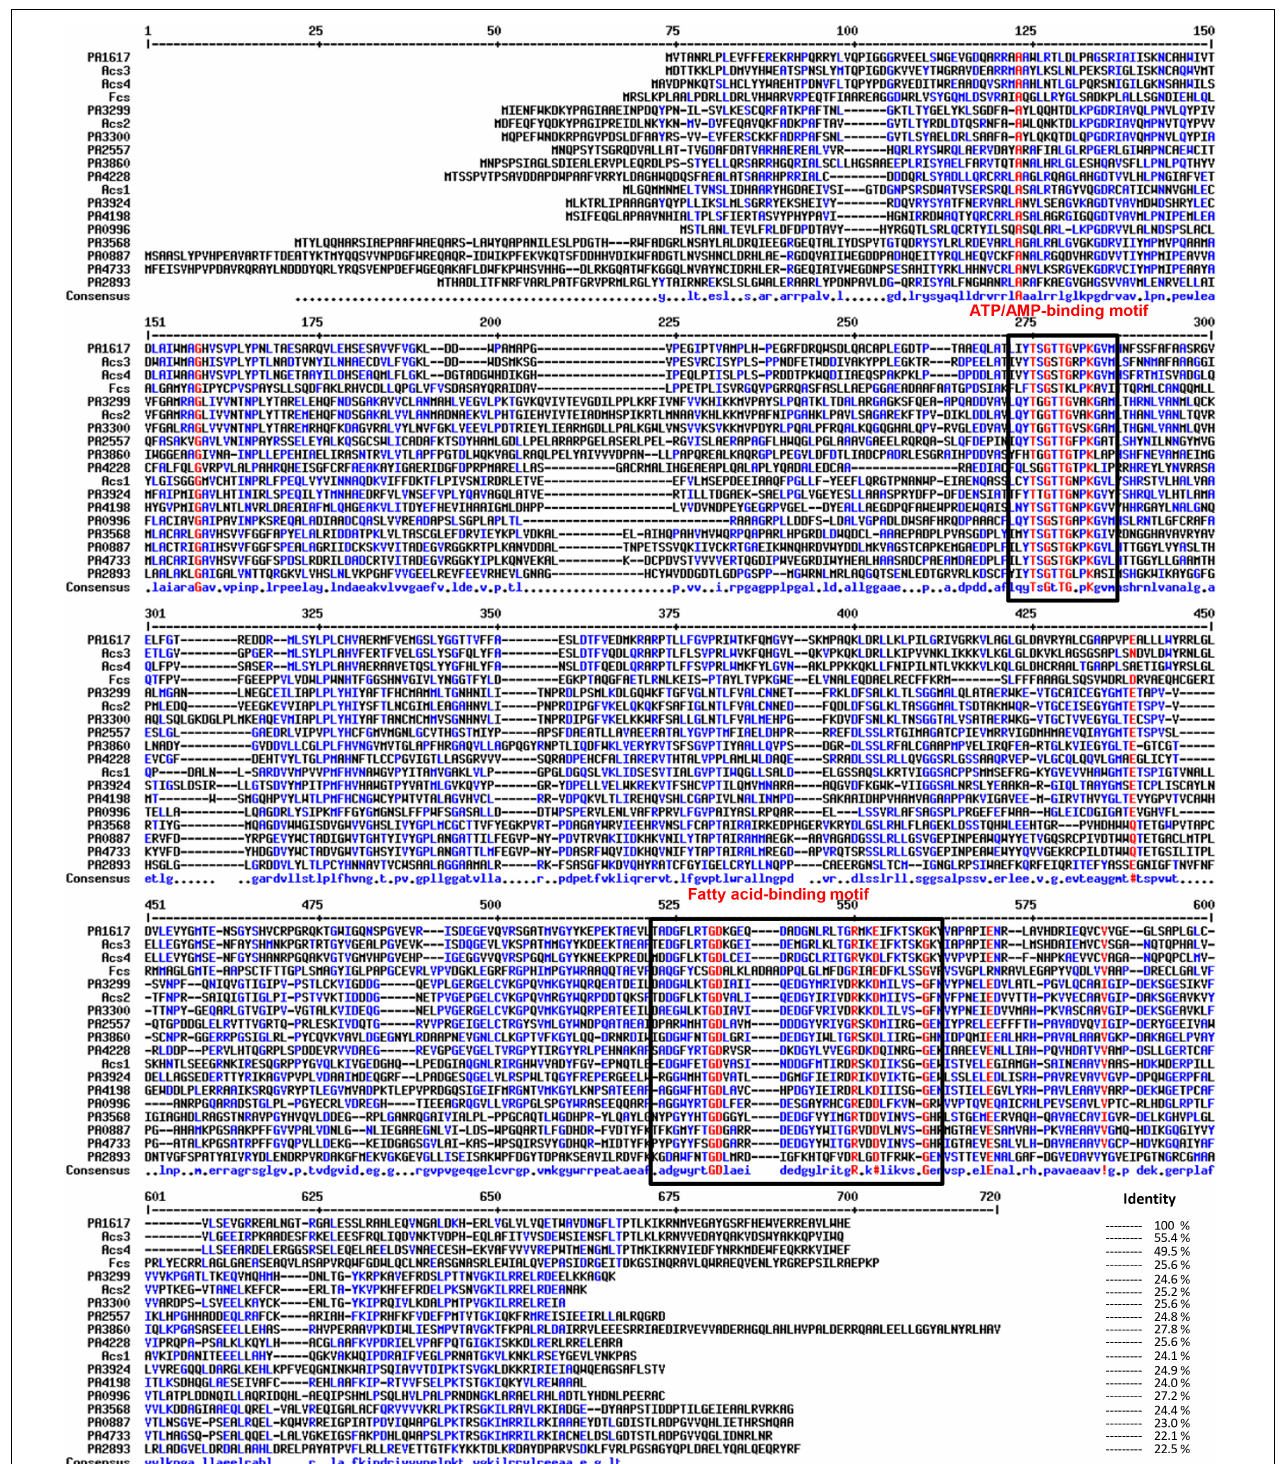
FIGURE 1 | Multiple sequence alignment of acyl-CoA synthetases from Pseudomonas aeruginosa PAO1. The ATP/AMP and fatty acid binding motifs are indicated by boxes. The accession numbers correspond to the following proteins used in the analysis: Acs1 (EF219372), Acs2 (EF219373), Acs3 (EF219374), and Acs4 (EF219375) from Marinobacter hydrocarbonoclasticus DSM8798 and feruloyl-CoA synthetase (Fcs; CAD60268) from Pseudomonas fluorescens BF13; from P. aeruginosa PAO1 genome, FadD1 (PA3299), FadD2 (PA3300), FadD3 (PA3860), FadD4 (PA1617), FadD5 (PA2893), FadD6 (PA3924), PA0887, PA0996, PA2557, PA3568, PA4198, PA4228, and PA4733. Multiple sequence alignments with hierarchical clustering were made using MultAlin software (Corpet, 1988).